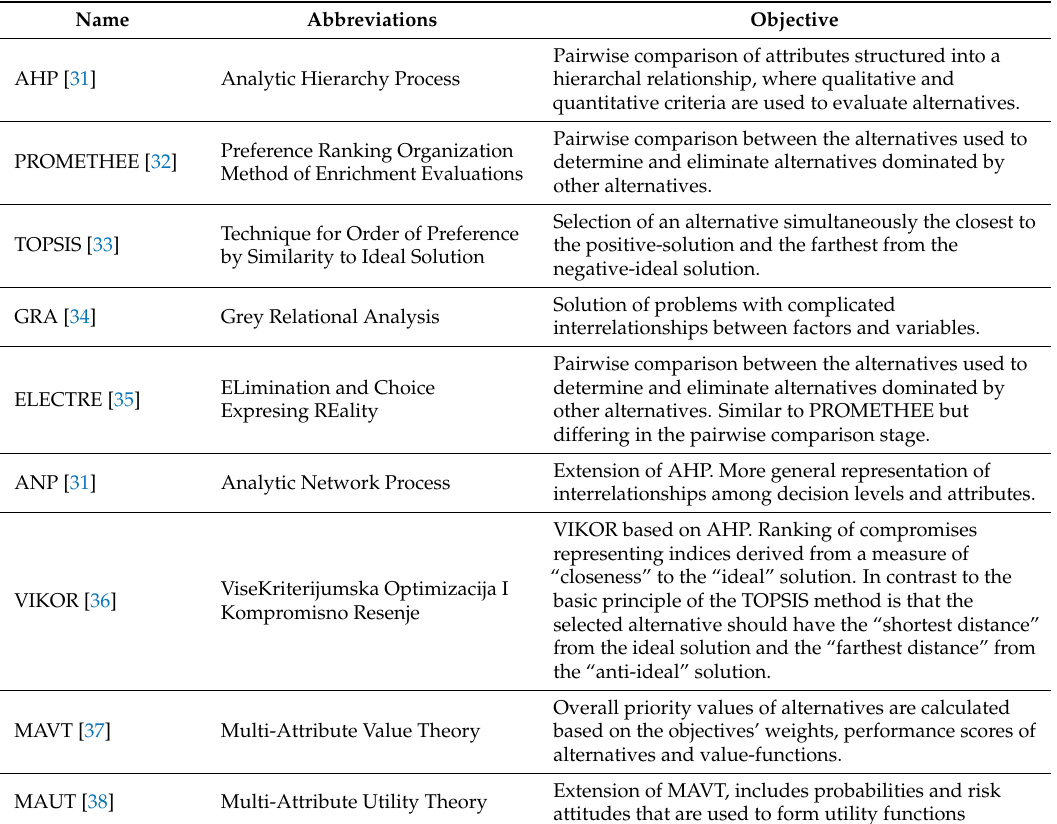
Table 2. Summary of different MCDA techniques and